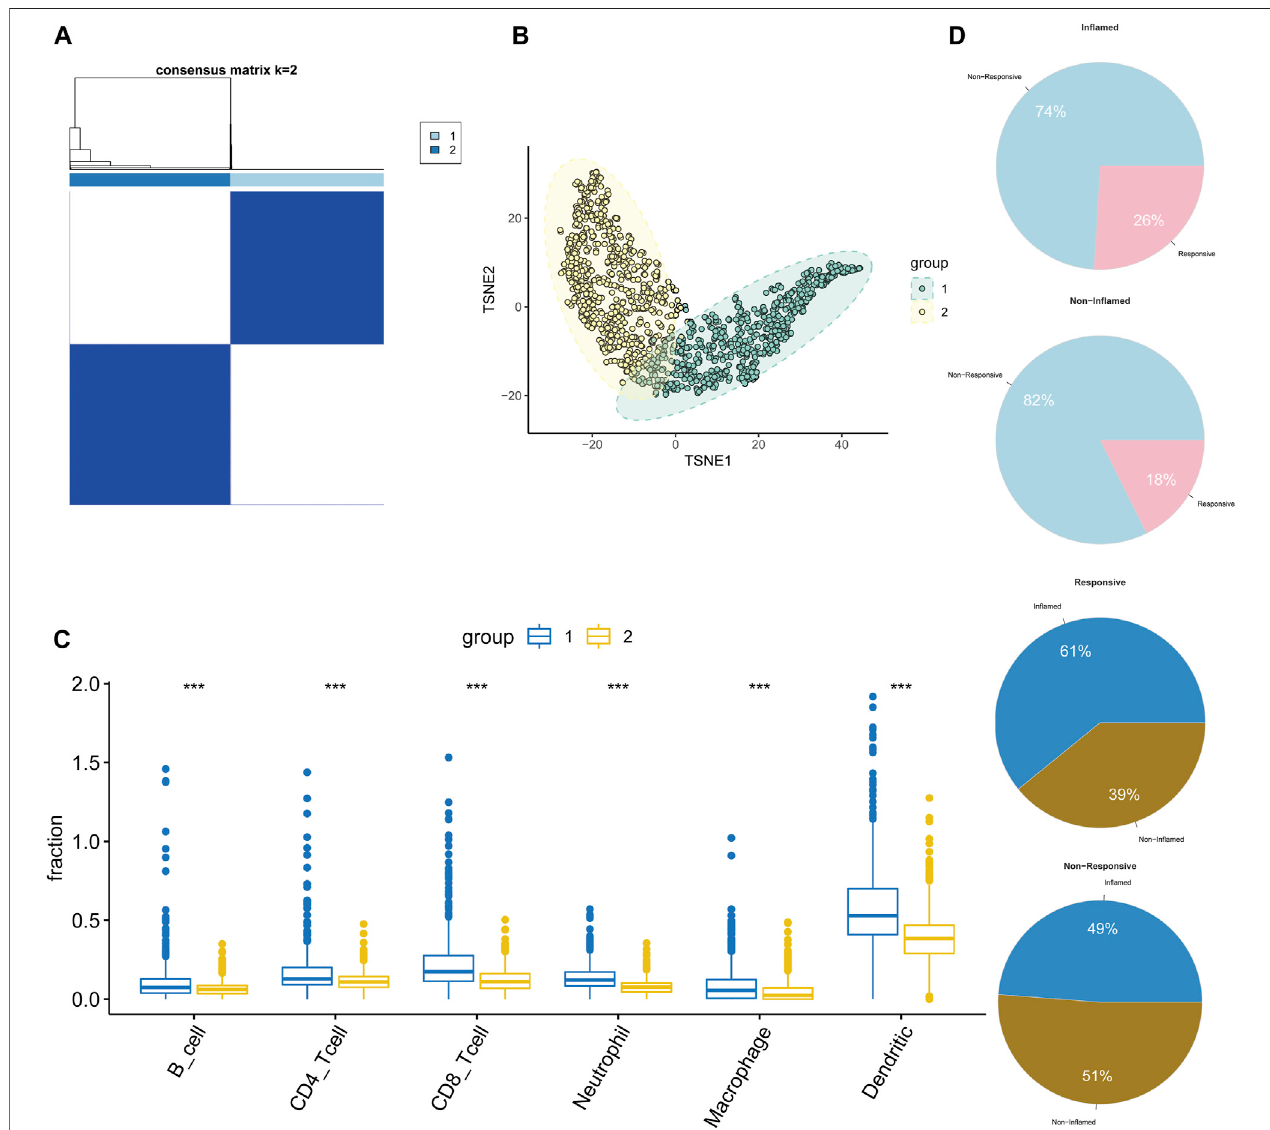
FIGURE 3 | Distinct molecular features of pan-cancer TME revealed by communication signature. (A) Two groups of TCGA pan-cancer by consensus clustering. (B) A t-SNE plot indicated remarkable separations. (C,D) The differences in in fi ltration levels of immune cells (C) and immunotherapy response (D) in two groups.